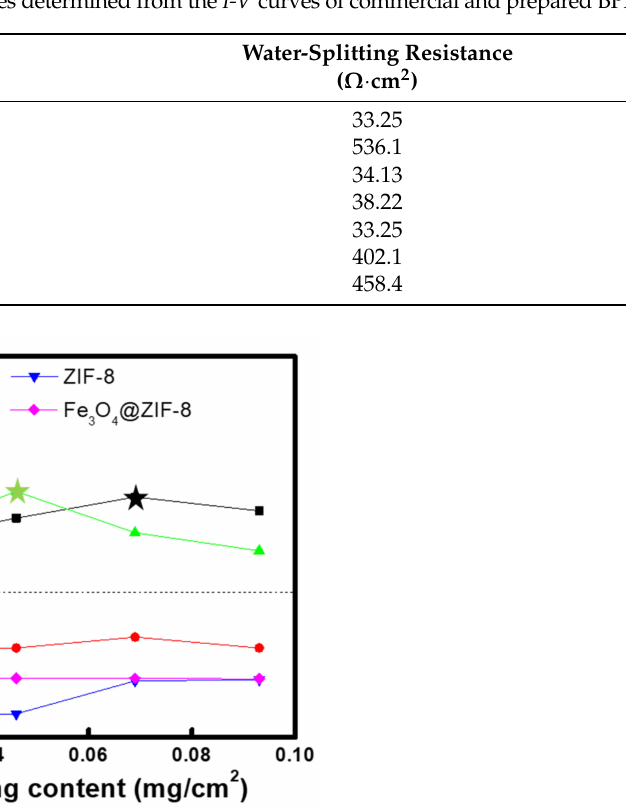
Figure 10. Current-voltage curves of commercial and fabricated BPMs. Table 4. Water-splitting resistances determined from the I-V curves of commercial and prepared BPMs.